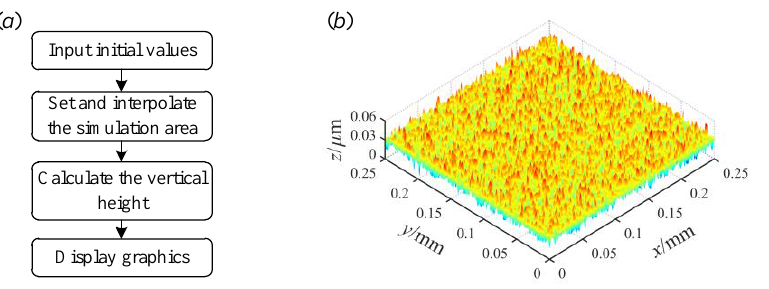
Figure 2. 3D fractal surface. ( a ) Modeling process; ( b ) 3D fractal surface under D = 2.5 and G = 1 × 10 −8 .